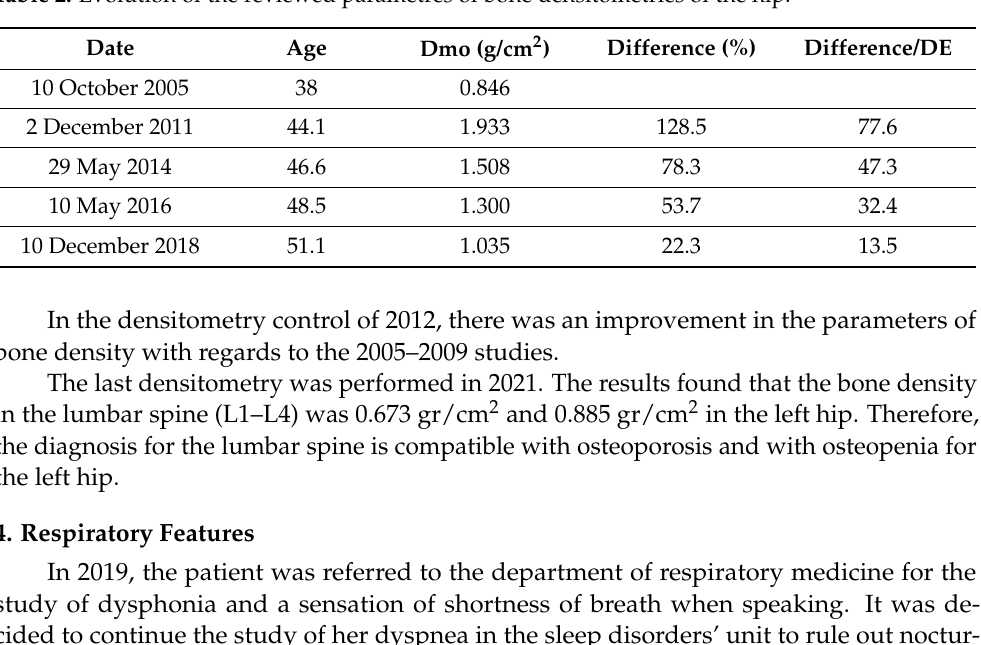
Table 2. Evolution of the reviewed parametres of bone densitometries of the